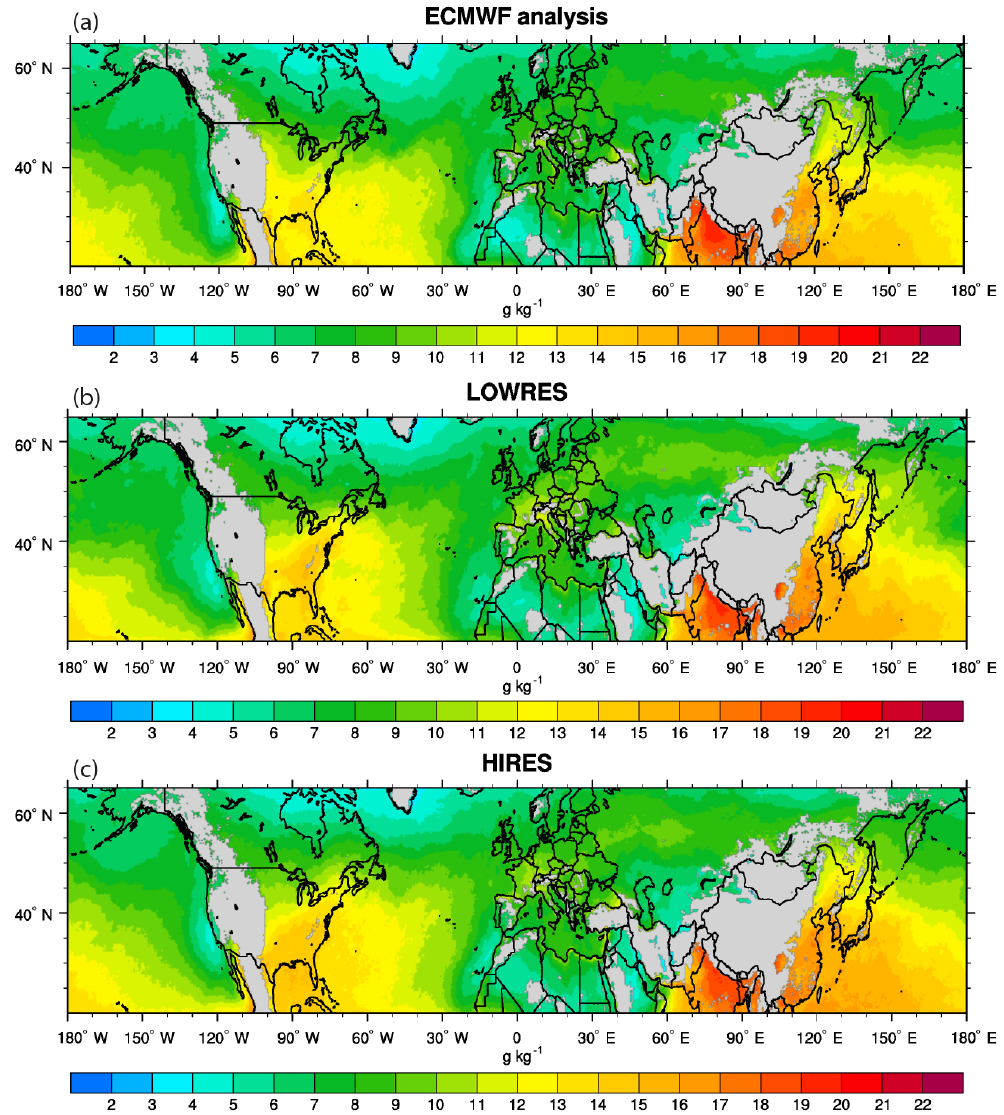
Figure 11. Average 925hPa water vapor mixing ratio for 12:00UTC of the ECMWF analysis (a) and the LOWRES simulation (b) . The bottom panel shows the HIRES